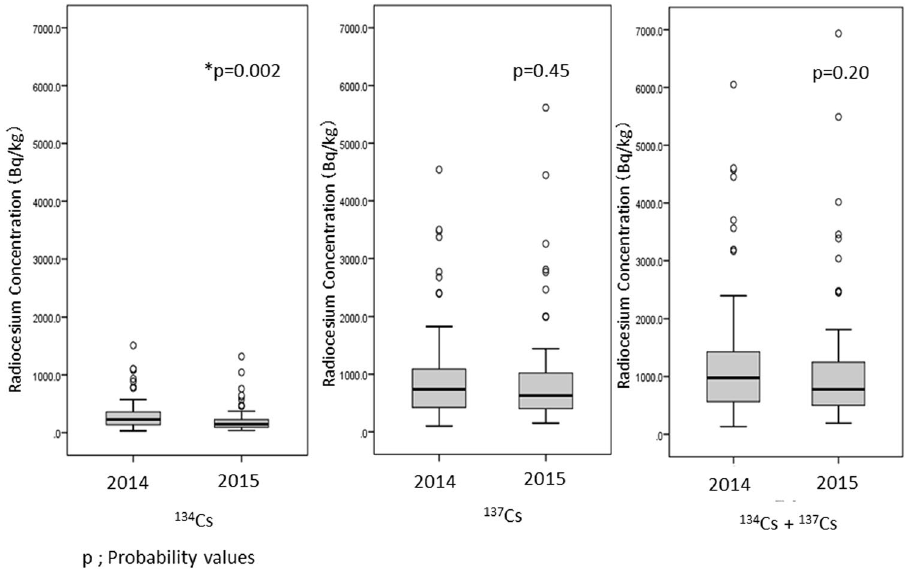
Figure 3. Comparison of concentrations of radiocesium of Sarcodon aspratus collected in 2014 and 2015.